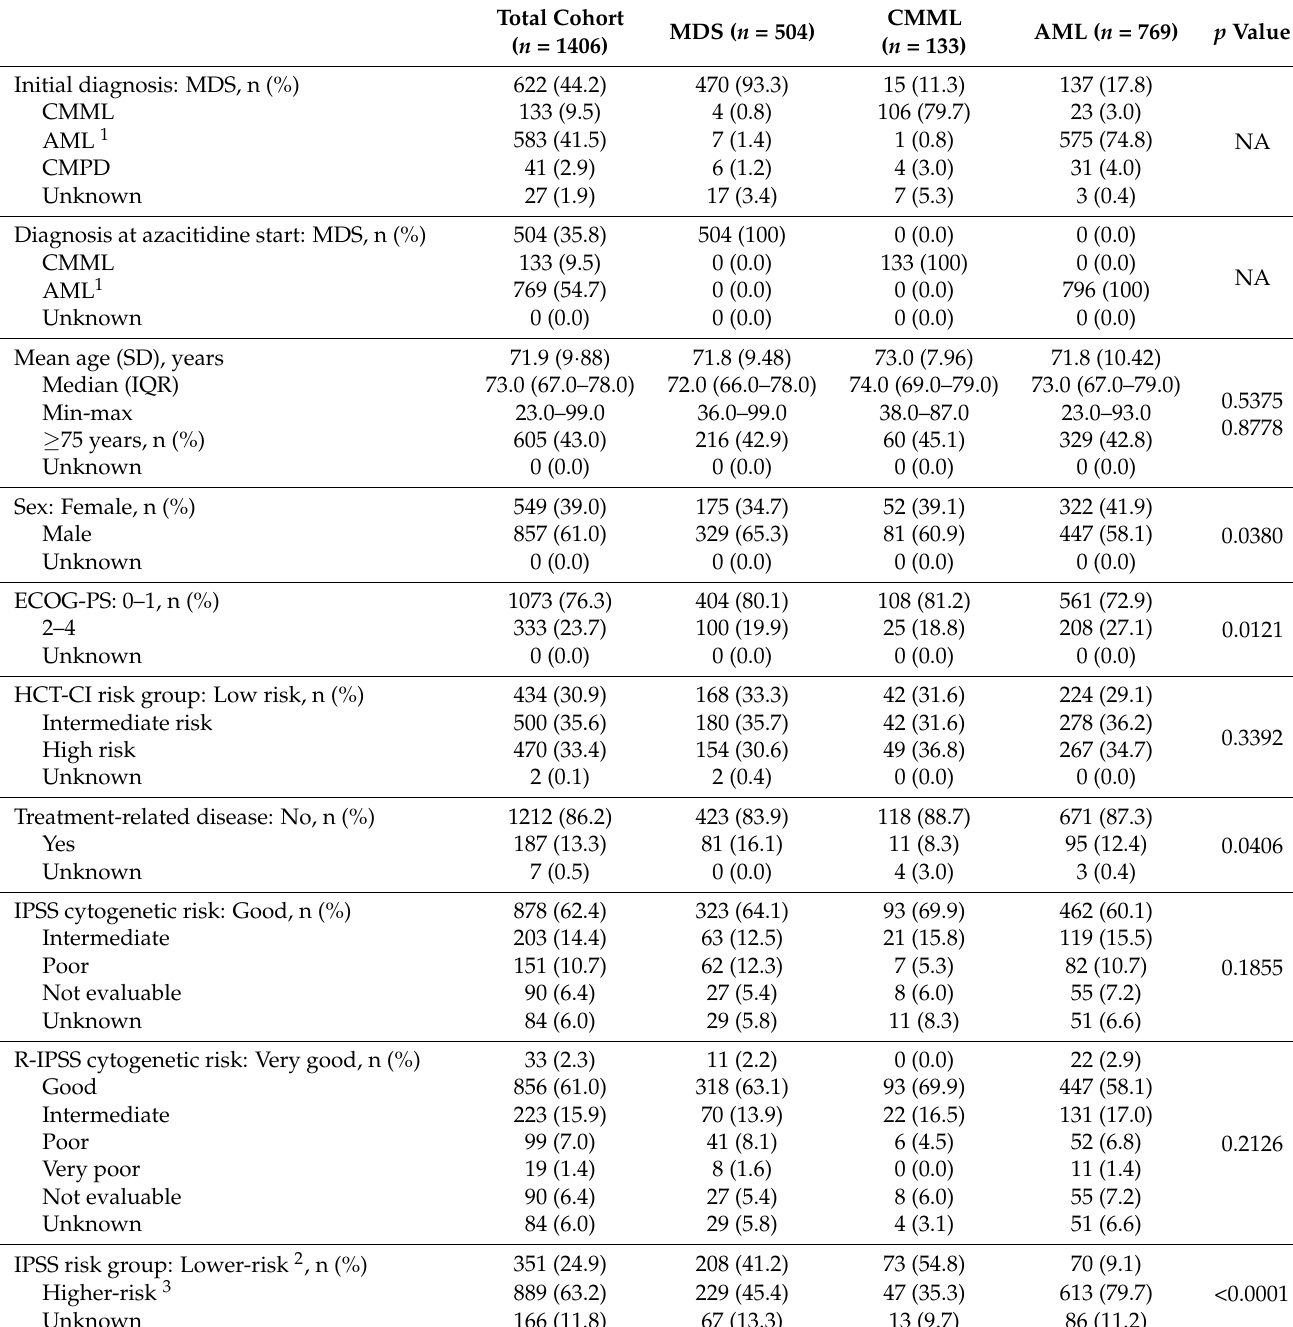
Table 1. Characteristics of patients included in the Austrian Registry of Hypomethylating Agents at azacitidine treatment